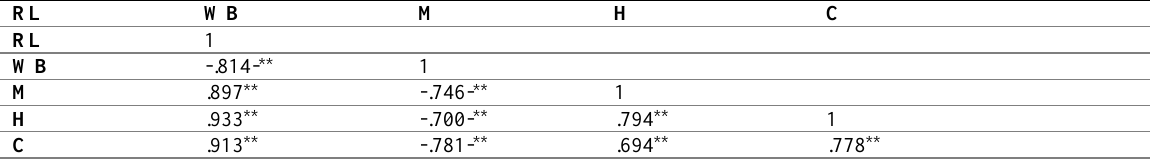
Table 10: Pearson Correlations for Independent Variable and Dependent